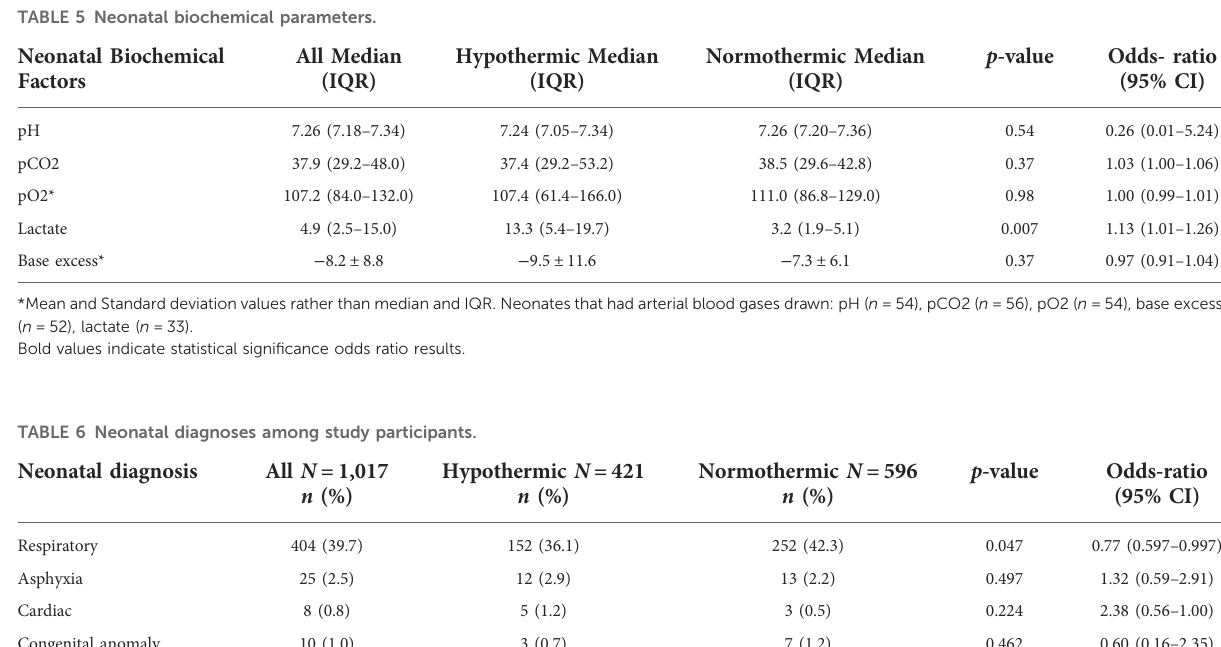
Bold values indicate statistical signi fi cance odds ratio